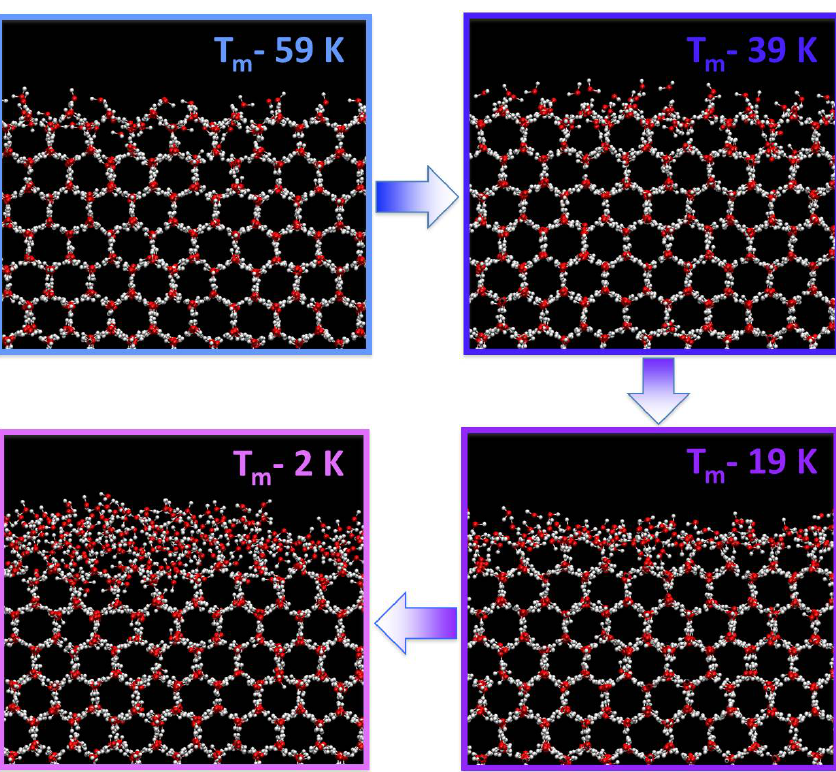
Fig. 8. Snapshots of the prismatic air–ice interface for selected simulations. The simulation temperatures correspond to undercooling of − 59K through − 2K relative to the melting point of the water model (NE6, T m = 289K). Reproduced from Gladich et al. (2011) with permission from the PCCP Owner